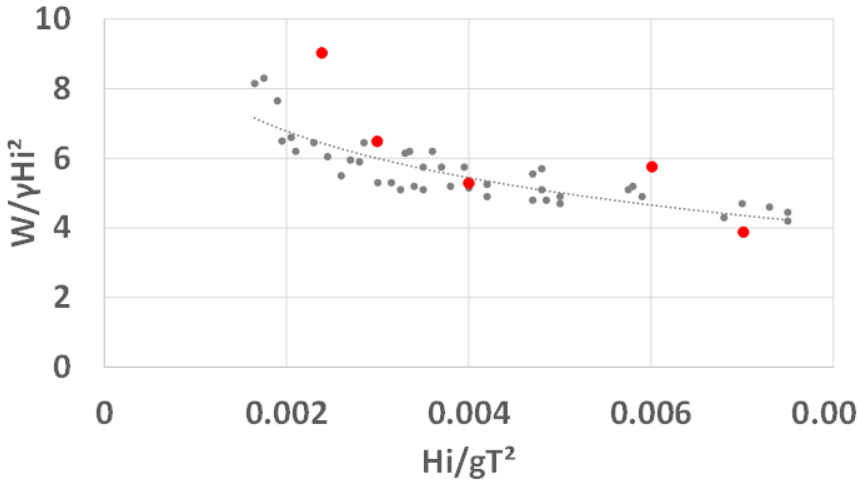
Figure 7. Monogram of experimental results (data from [22])—gray dots) and results obtained from numerical simulations of scenarios 1 to 5 (red dots).